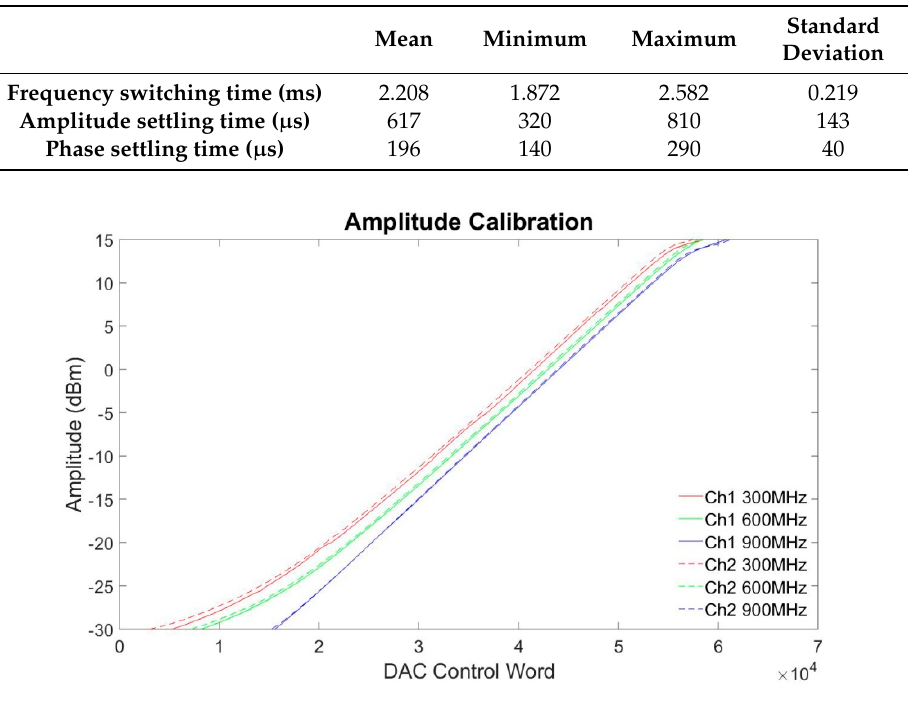
Figure 2. Amplitude calibrations for two channels at three frequencies: 300 MHz, 600 MHz and 900 MHz.